Question: What caption would you write for this figure?
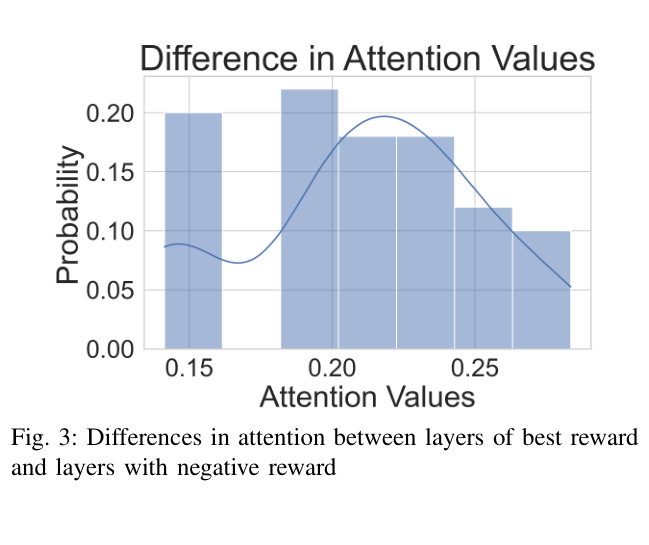
Answer: summarizes the distribution of layer combinations with negative rewards. Two combinations stand out, Class 1 represented by Conv2D and Conv2D combinations and Class 2 represented by two consecutive FCLs. A layer combination refers to the layer that produced a negative reward and its previous layer. Two main insights can be gathered from Figure 2. The first is that the negative reward is overwhelmingly attributed to the accumulation of FCLs. This means that the stacking of multiple FCL layers is superfluous on the MNIST dataset, a conclusion that aligns with the best models obtained in [6]. The second insight highlights that additional Conv2D layers can degrade model performance, especially with MNIST data of limited visual complexity. As such, these observations are beneficial to garner knowledge about stacking of layers, suitable for environments with resource constraints. Figure 3 depicts the distribution of the differences in at- tention values between layers with the best